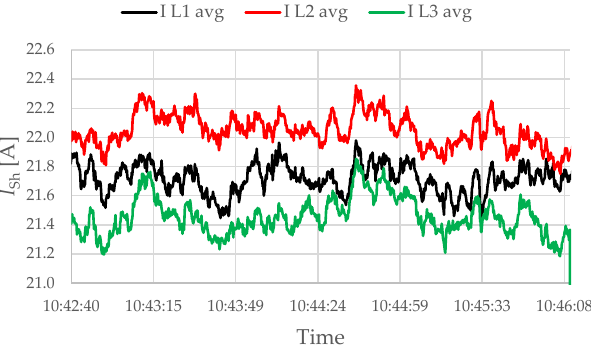
Figure 7. Sheaths currents measured at Substation 2 in direction to Substation 1. Actual operating system of sheaths (Sh1). Operation only with the analyzed line.